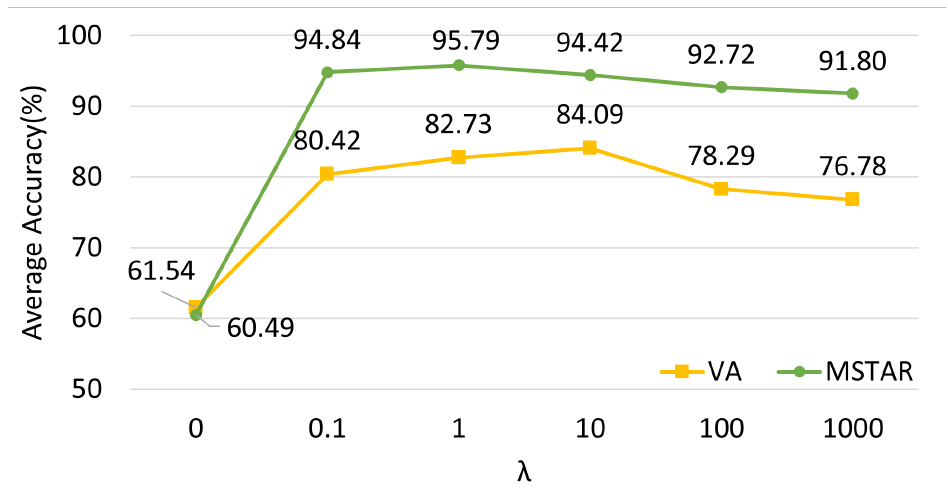
Figure 14. The accuracy of our method under different λ on VA and the MSTAR